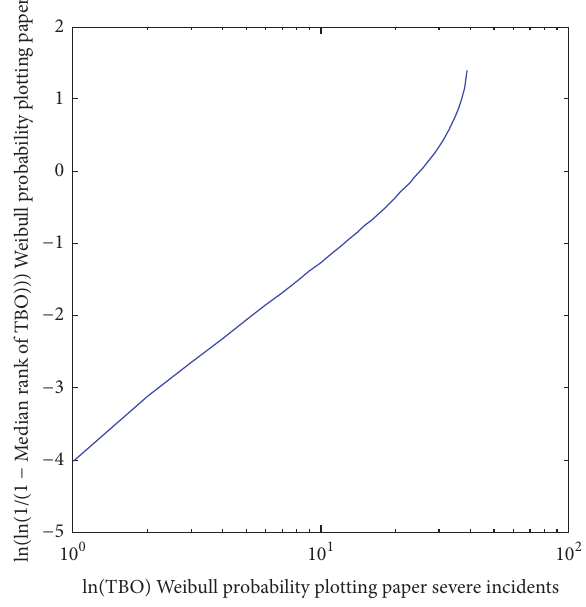
Figure 3: Weibull paper for severe incident 2010 to 2015.